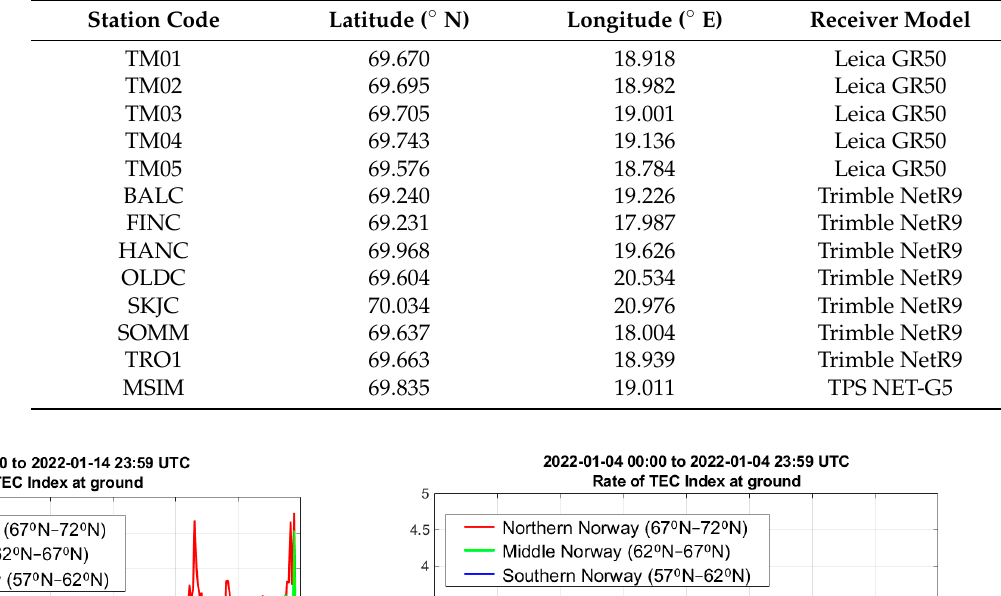
Table 1. List of the receivers included in the cluster indicating location and receiver model.